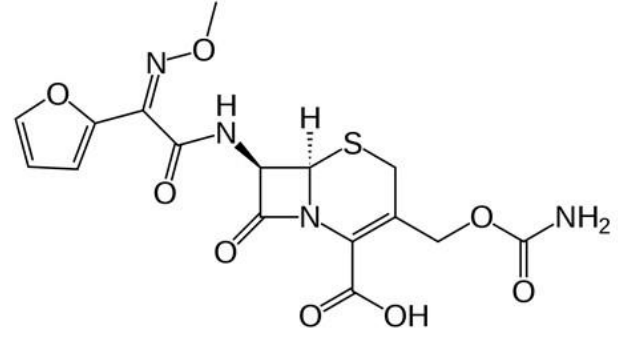
Figure 1. Cefuroxime structure.